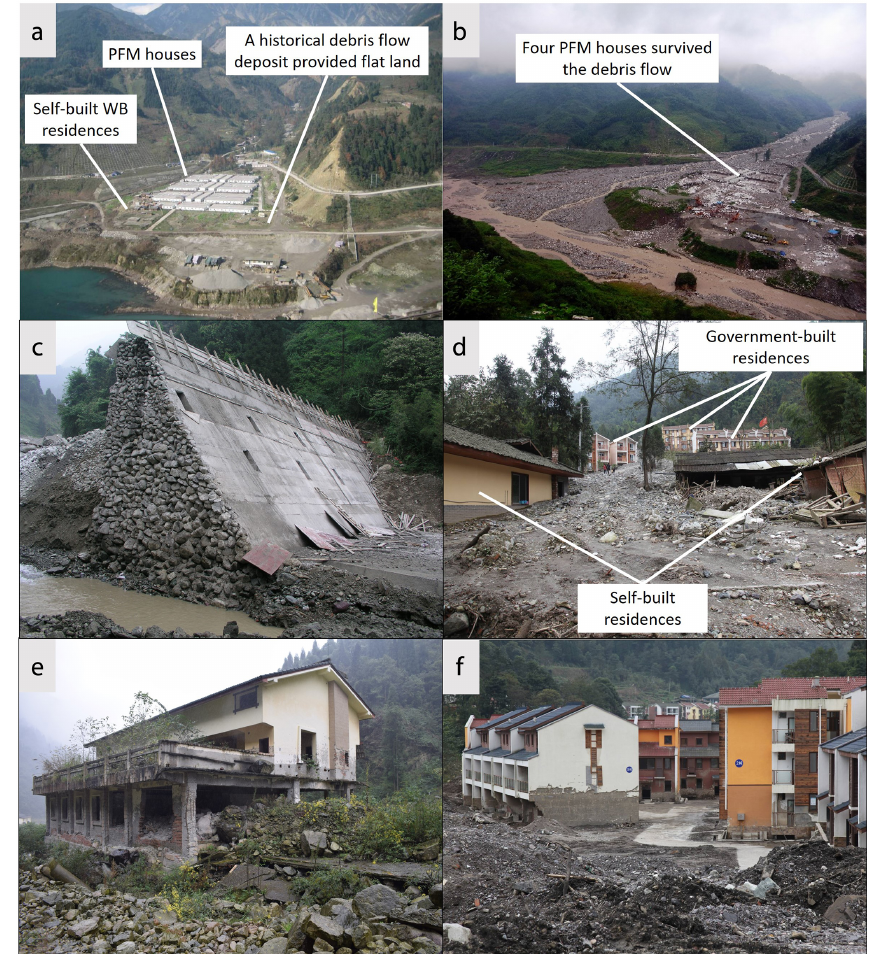
Figure 8. Losses caused by the 14 August 2010 debris flows. The locations of the examples are shown in Fig. 7. (a) The temporary settlement at the Bayi subcatchment outlet in 2009 (Luo et al., 2010). (b) The shelters destroyed by a debris flow from the Bayi subcatchment (Luo et al., 2010). (c) One of the two underdesigned check dams in Bayi subcatchment which were destroyed (Liu et al., 2010). (d) Residences reconstructed on old debris flow deposits which were damaged. (e) A hotel beside the Longxi River was struck. (f) Government-built apartment buildings beside the river which were